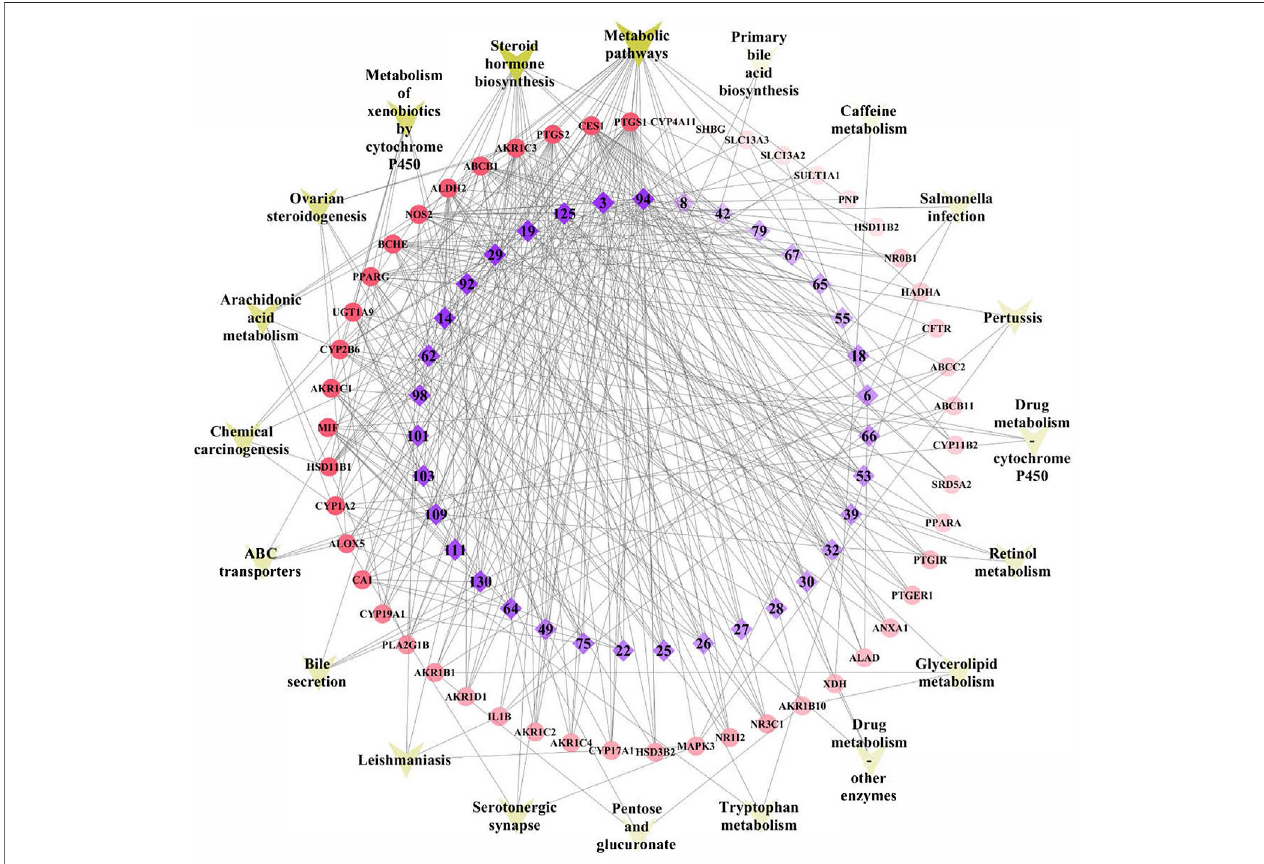
FIGURE 6 | Tongfengding capsule (TFDC) key components – major targets – main pathways network. Innermost and purple diamond represents the 35 validated compounds of TFDC, the middle and red circle stands for the 50 gout-related targets, and the outermost “ V ” shape in yellow indicates the 20 enriched Kyoto Encyclopedia of Genes and Genomes (KEGG) pathways. Edges represent interactions among the key components, targets, and pathways.